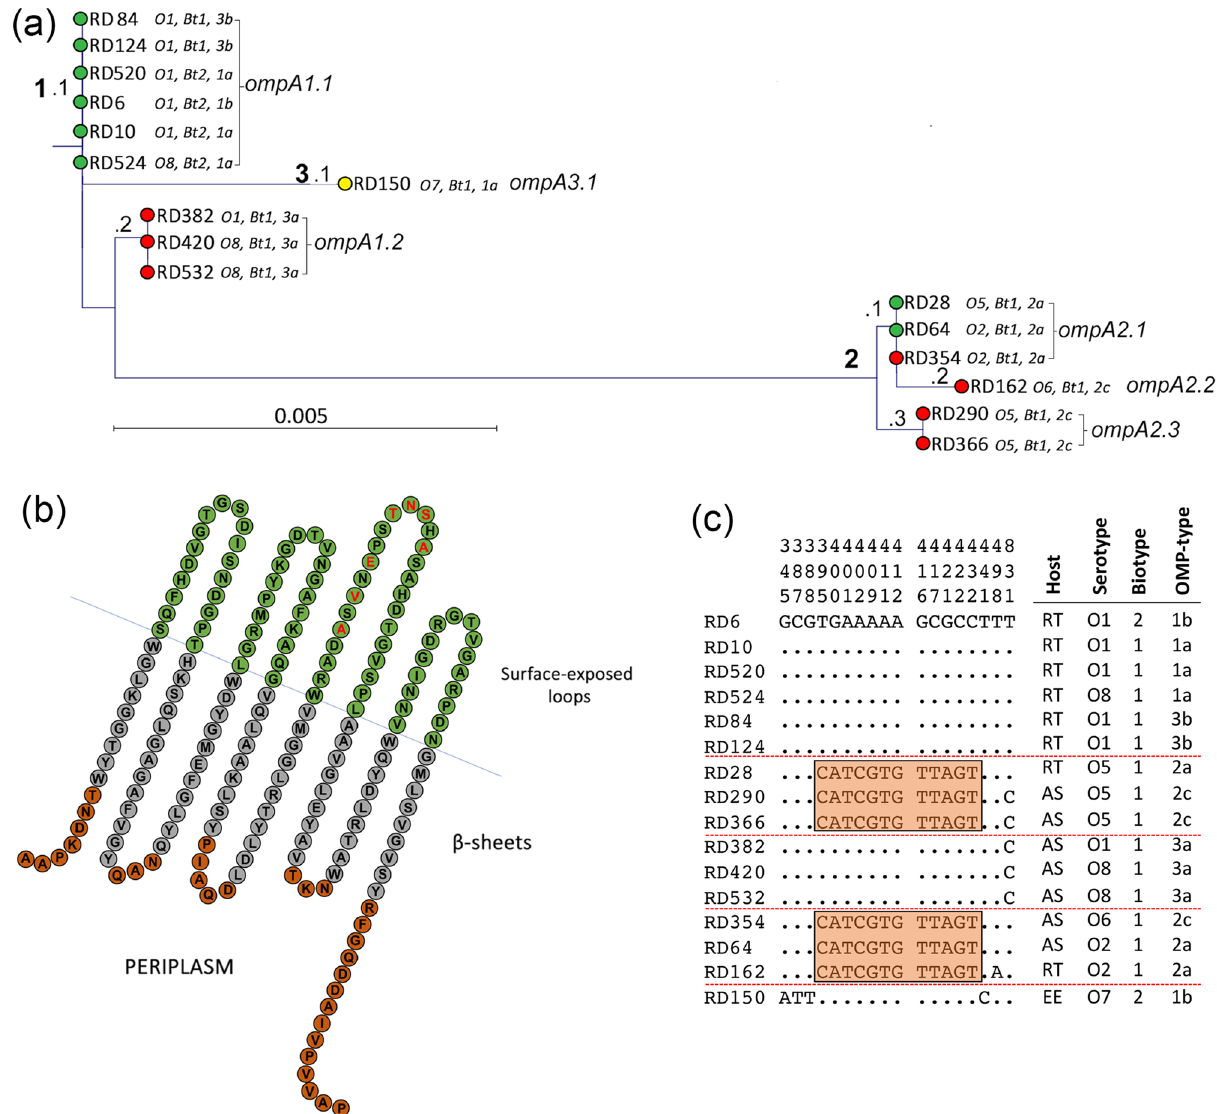
Figure 2. Variation with the protein sequence of OmpA is confined to a hypervariable region of loop 3. ( a ) Phylogenetic relatedness of ompA amongst 16 isolates of Y. ruckeri. Isolates were recovered from rainbow trout (green), Atlantic salmon (red) and European eel (yellow). The tree was constructed using the Jukes–Cantor correction for synonymous changes. Distinct variants are indicated by i–iii and reflect Supplementary Fig. S1. ( b ) The proposed secondary structure the OmpA protein of Y. ruckeri . The sequence is based on OmpA of strain ATCC29473. The periplasmic turns are shown in red, the β-sheets in grey and the surface exposed loops in green. Variable amino acids are shown in bold red and correspond with the sequence alignment in Supplementary Fig. S1. Domains were predicted using Pred TMBB based on Hidden Markov Models (HMM). Sequences at both N- and C-terminals are truncated. Distribution of polymorphic nucleotide sites among ompA alleles in reference isolates ( c ). The numbers above the sequences represent the positions of polymorphic nucleotide sites from the 5 ′ end of the gene. The dots represent sites where the nucleotides match those the first sequence (RD6). The boxes highlight regions of sequence identity that represent proposed recombinant